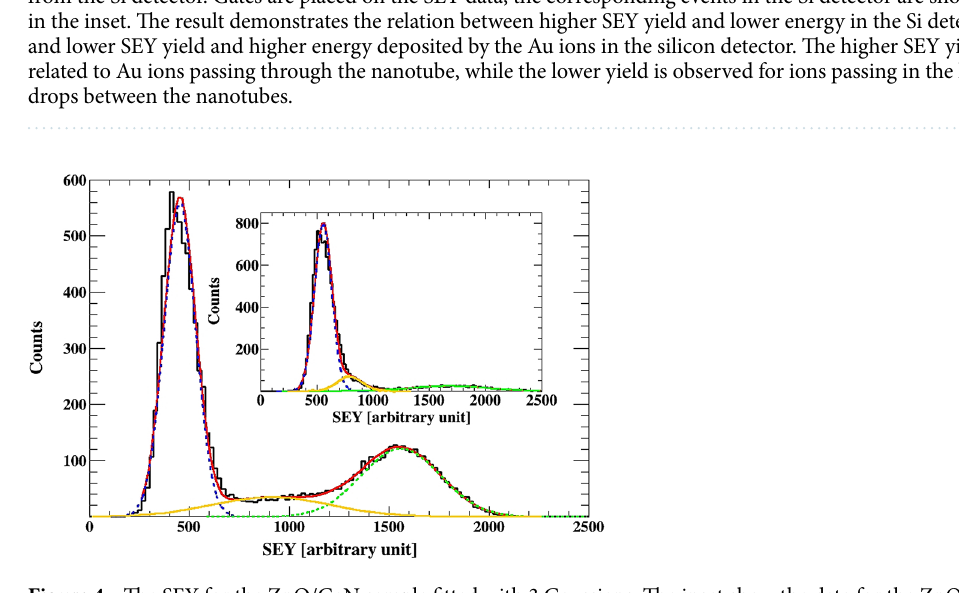
Figure 4. The SEY for the ZnO/GaN sample fitted with 3 Gaussians. The inset show the data for the ZnO sample (without GaN coating). The ratio of the area under the high SEY distribution and the total number of counts in the SEY spectra is 0.3 for the ZnO/GaN sample, and 0.1 for the ZnO sample. These are consistent with the geometrically calculated ration of 0.3–0.5 and 0.11–0.16,